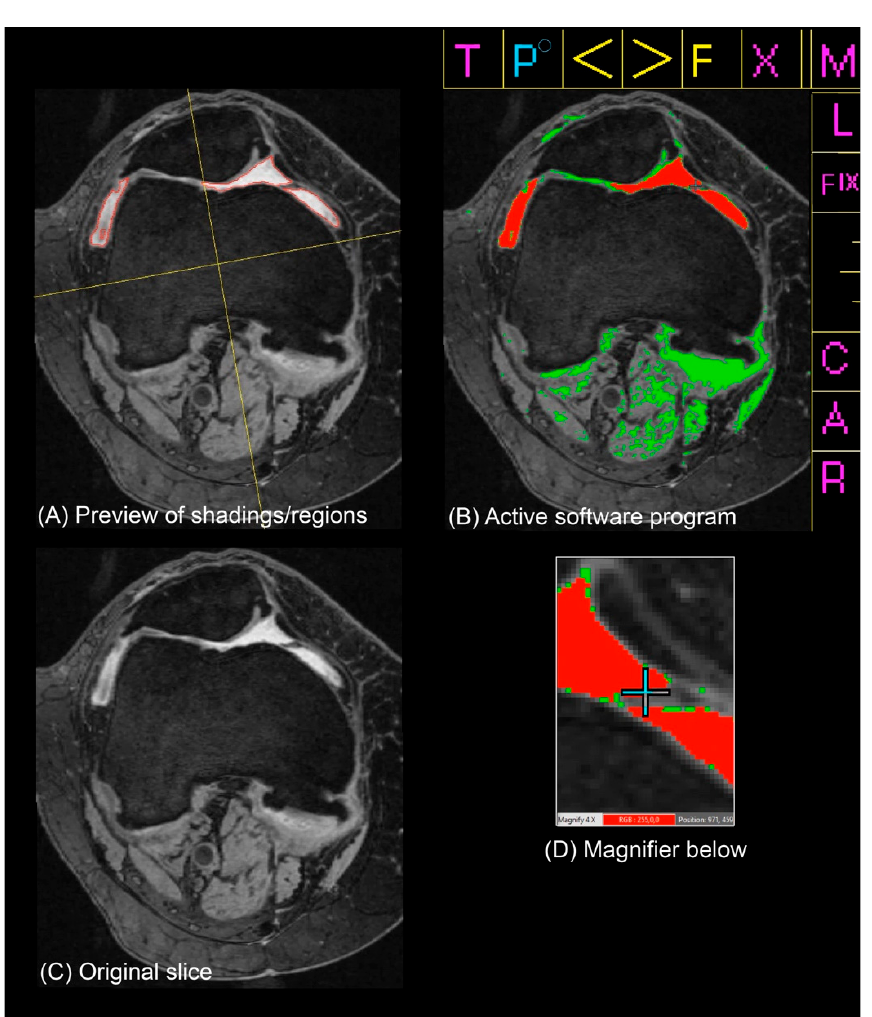
Figure 2. Software system and effusion-synovitis (ES) measurement method used to generate ES shadings and subregional divisions and verify/revise areas of fine detail. Panels ( A – D ) were viewed simultaneously by a reader in a single display (without the captions). ( A ) Preview of shadings and regions generated in the top left portion of the screen. ( B ) Active software program in the top right corner of screen. ( C ) Original slice below the preview of shadings/regions. ( D ) Magnifier on the cursor below the active program.